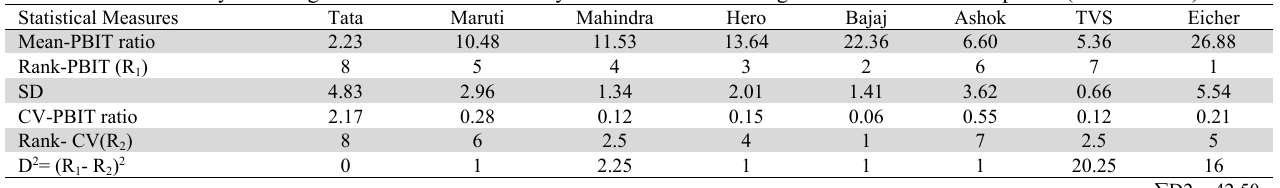
Relational Co-variability of average PBIT ratio and variability of PBIT ratio of leading Indian automobile companies (2011 to 2020) Statistical Measures Tata Maruti